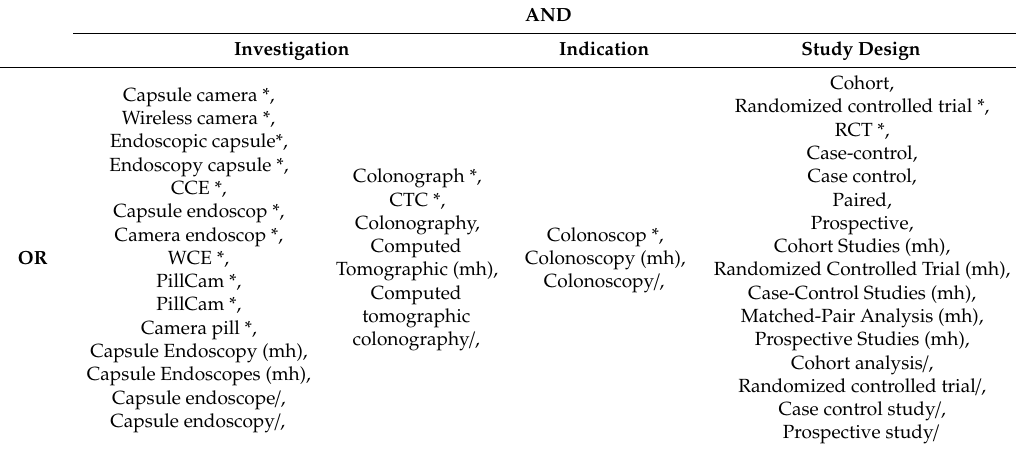
Table A1. Search strategy to identify the relevant studies on colon capsule endoscopy vs. CT colonography following incomplete colonoscopy.